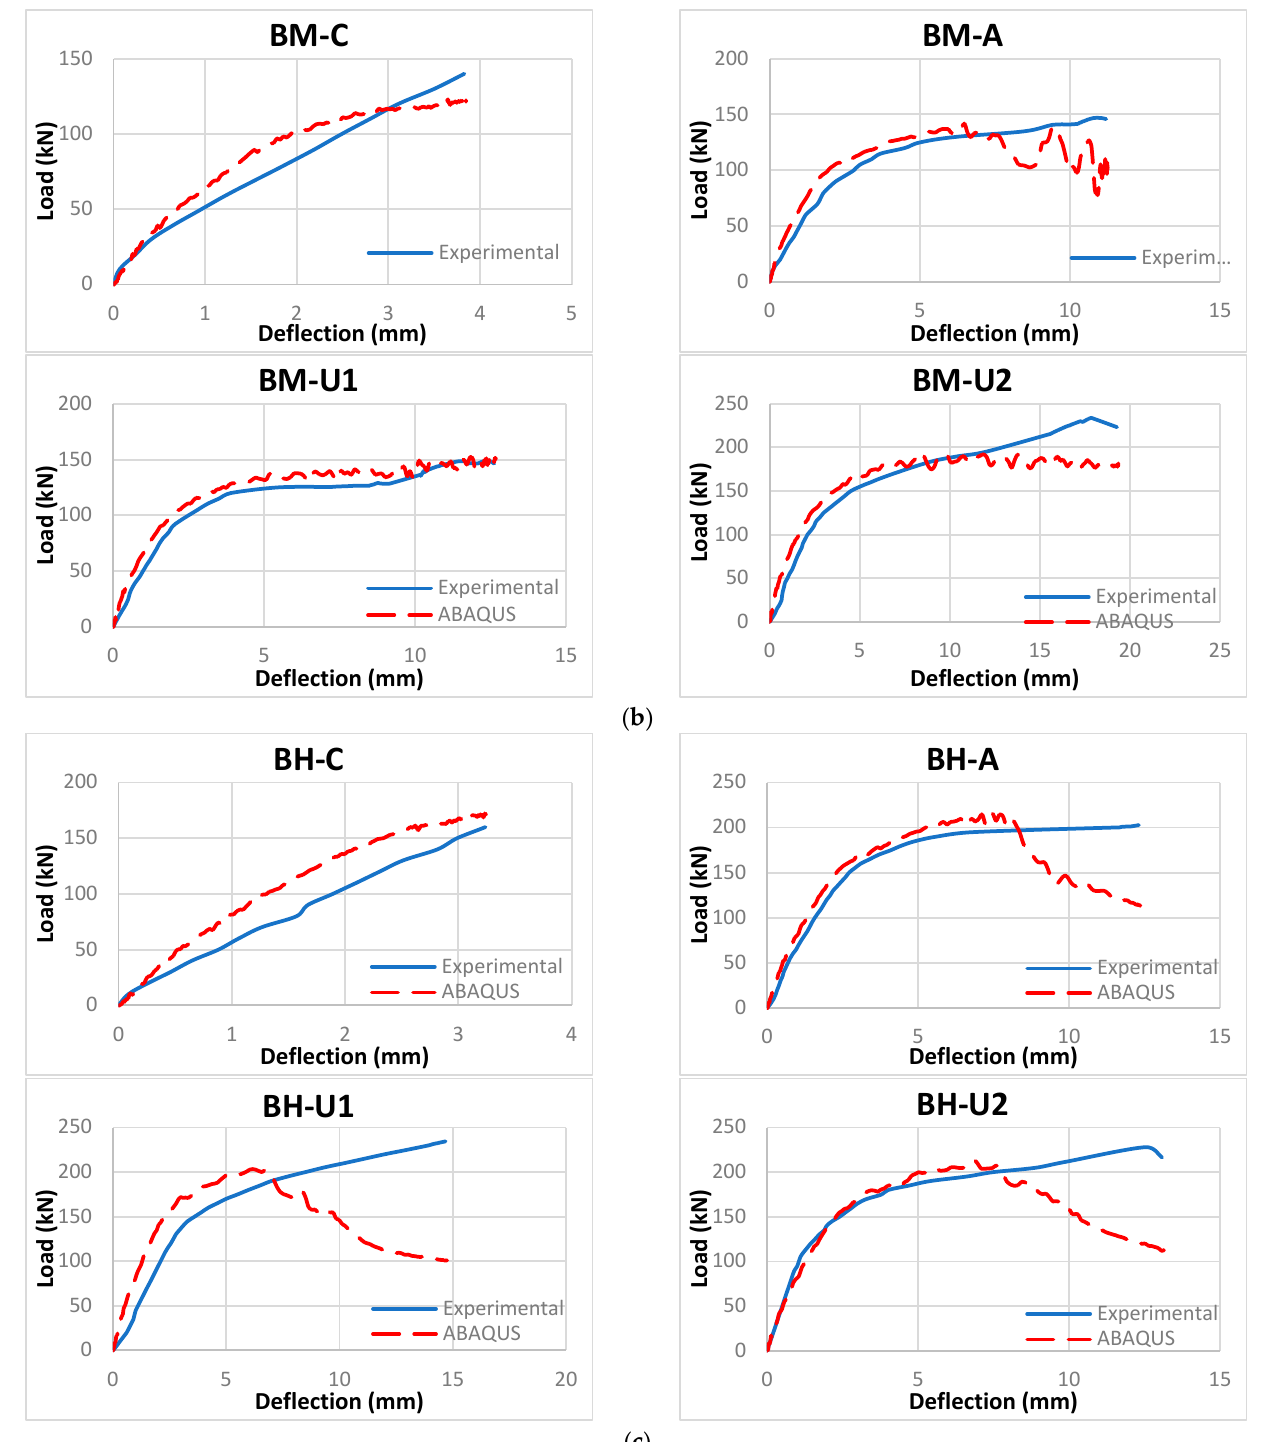
Figure 17. Comparison between the experimental and ABAQUS load ‐ deflection behavior: ( a ) low strength concrete, ( b ) medium strength concrete, and ( c ) high strength concrete.